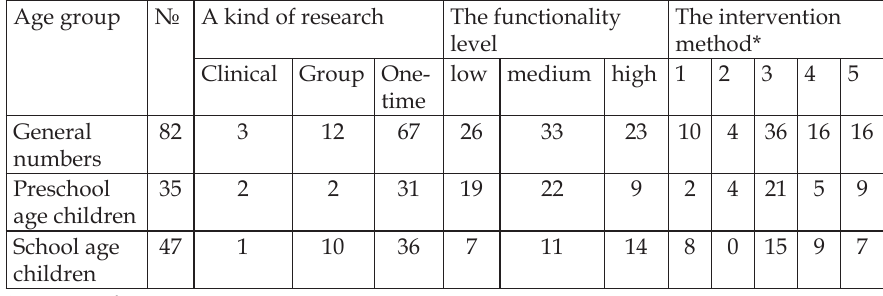
Table 1. The characteristic of social interventions aimed at social skills forming in children with autism spectrum disorder (*The fi gures correspond to method of intervention described in the above